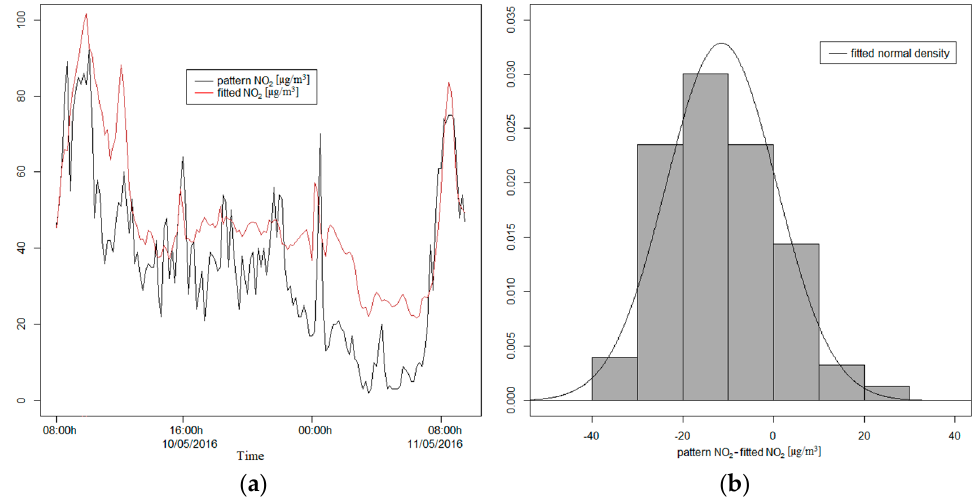
Figure A2. Both graphs with the test dataset. ( a ) The fitted values by the model and the pattern values for nitrogen dioxide; ( b ) the histogram of the net prediction errors of the model. Table A3. The table contains the summary of the model described in Equation (5) adjusted to the dataset with all